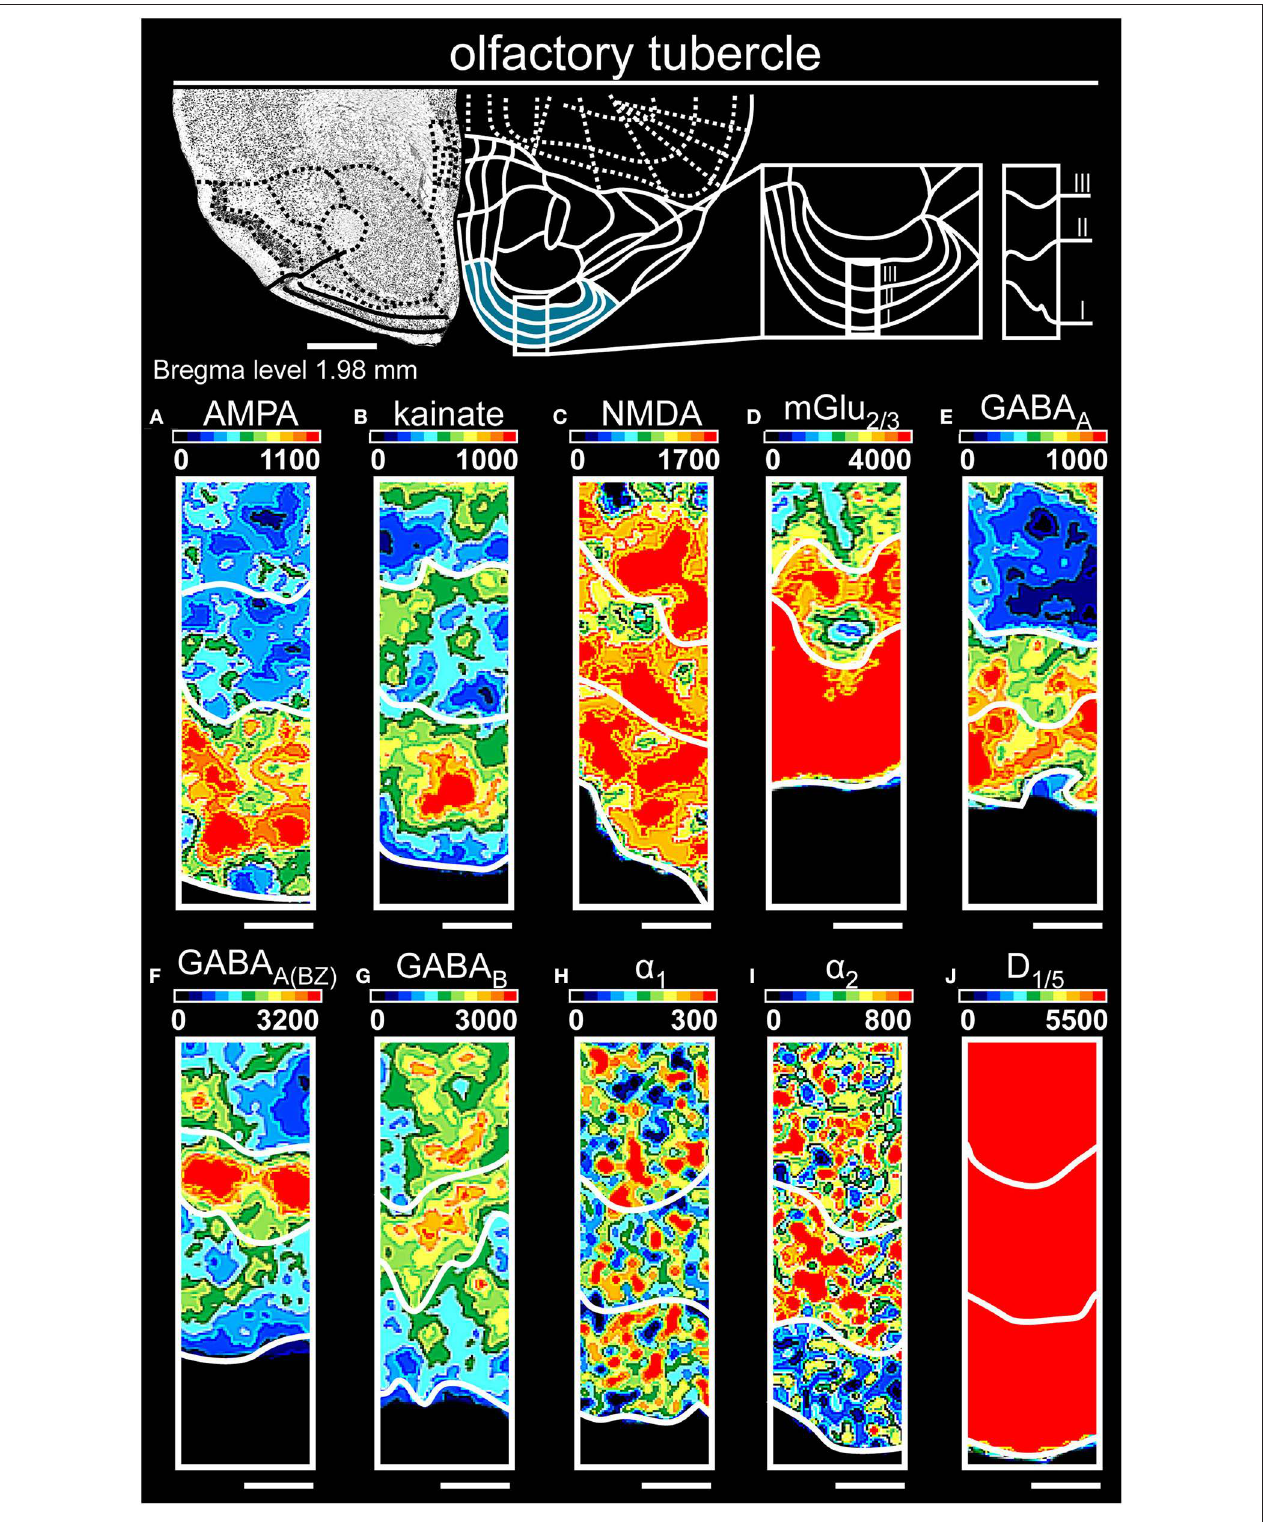
FIGURE 7 | Color-coded autoradiographs showing the distribution and density of all investigated receptors of the olfactory tubercle. Densities of the color-coded autoradiograms in fmol/mg protein according to color scales. For detailed receptor densities see Table 1 . Scale bars: Atlas, 1.2mm; (A–J) , 400 µ m. I, layer 1; II, layer 2; III, layer